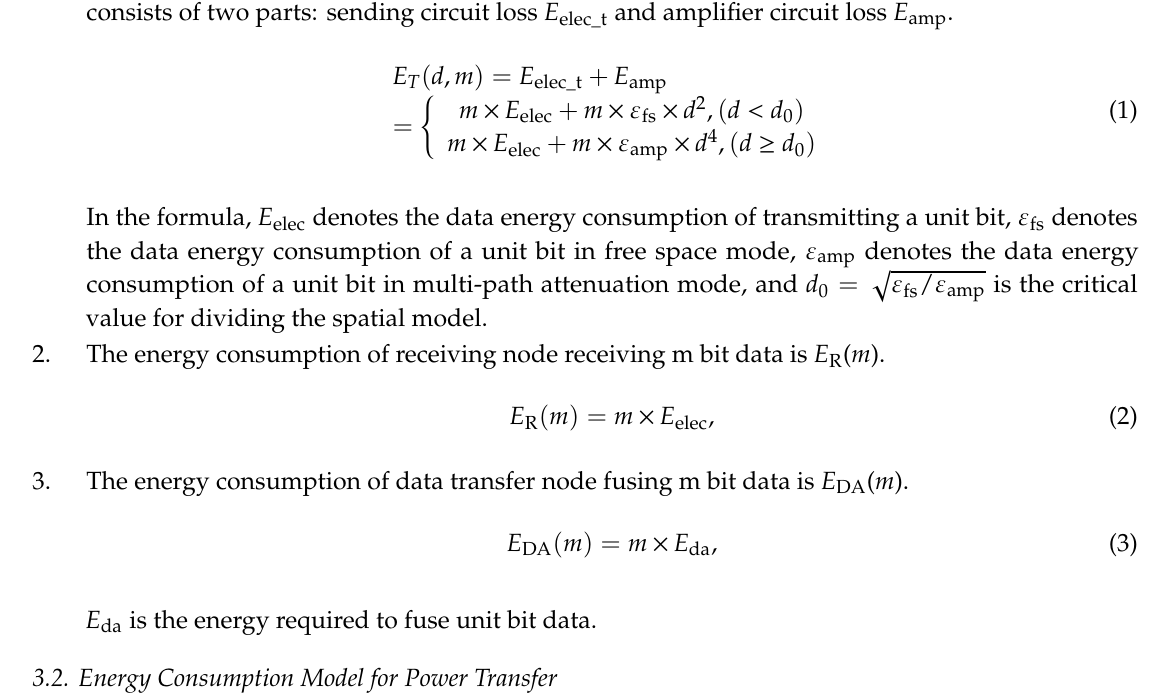
Figure 3. Radio energy consumption model.